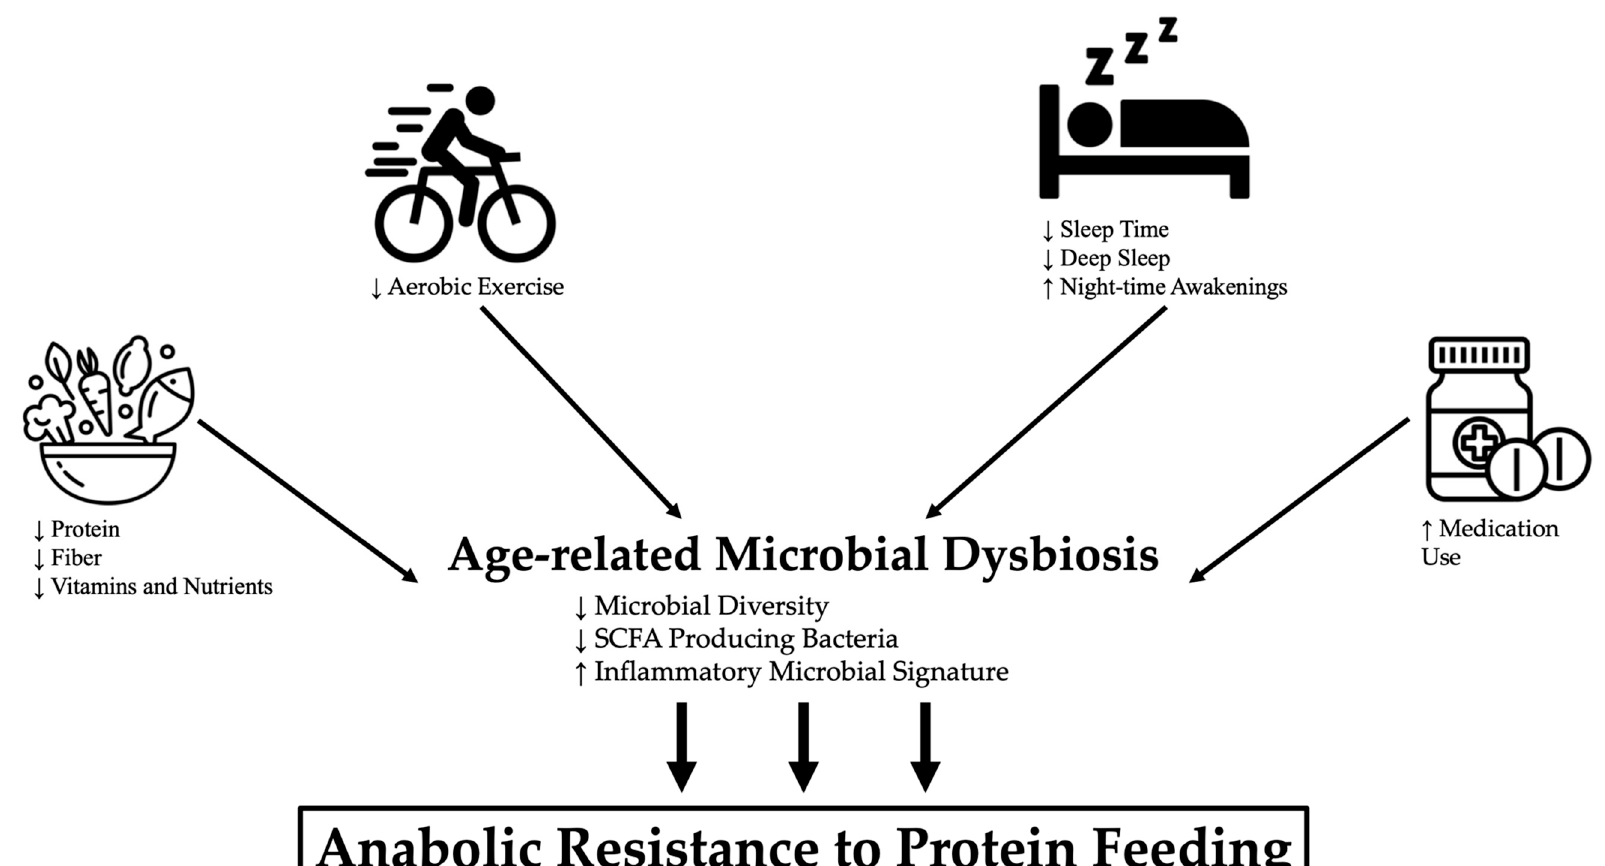
Figure 2. Downstream effects of modifiable lifestyle factors on microbial dysbiosis and anabolic resistance. Deleterious changes in modifiable lifestyle factors (e.g. diet, exercise, sleep, polypharmacy) commonly observed with aging promote microbial dysbiosis and consequential anabolic resistance to protein feeding. ↑ = increased; ↓ = decreased